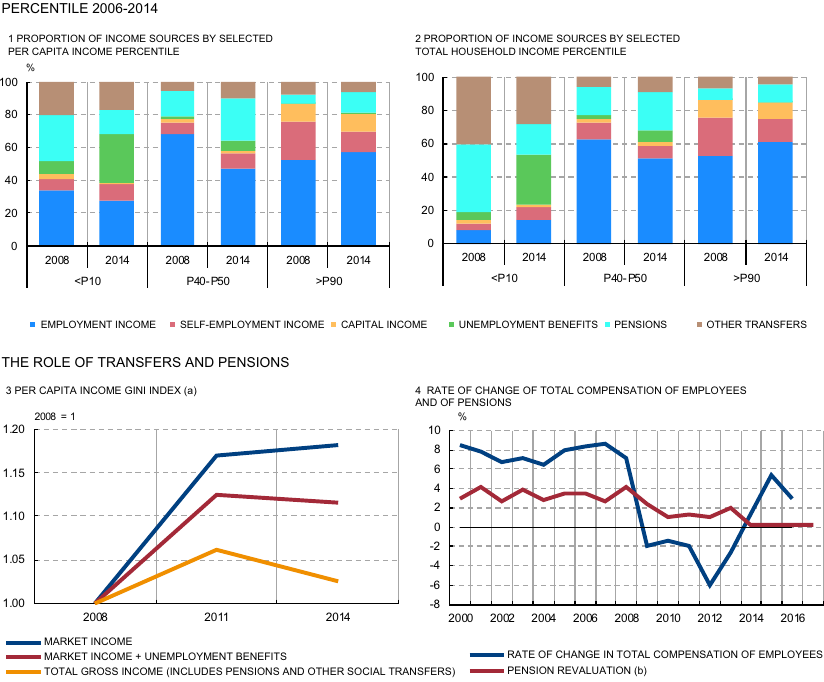
Fig. 9 Theroleofdifferentsourcesofincome.a.HouseholdincomeadjustedusingOECDequivalencescale. b. Pension revaluation including safeguard clause from previous year. Sources : Social Security, National Statistics Institute (EPA) and Banco de España